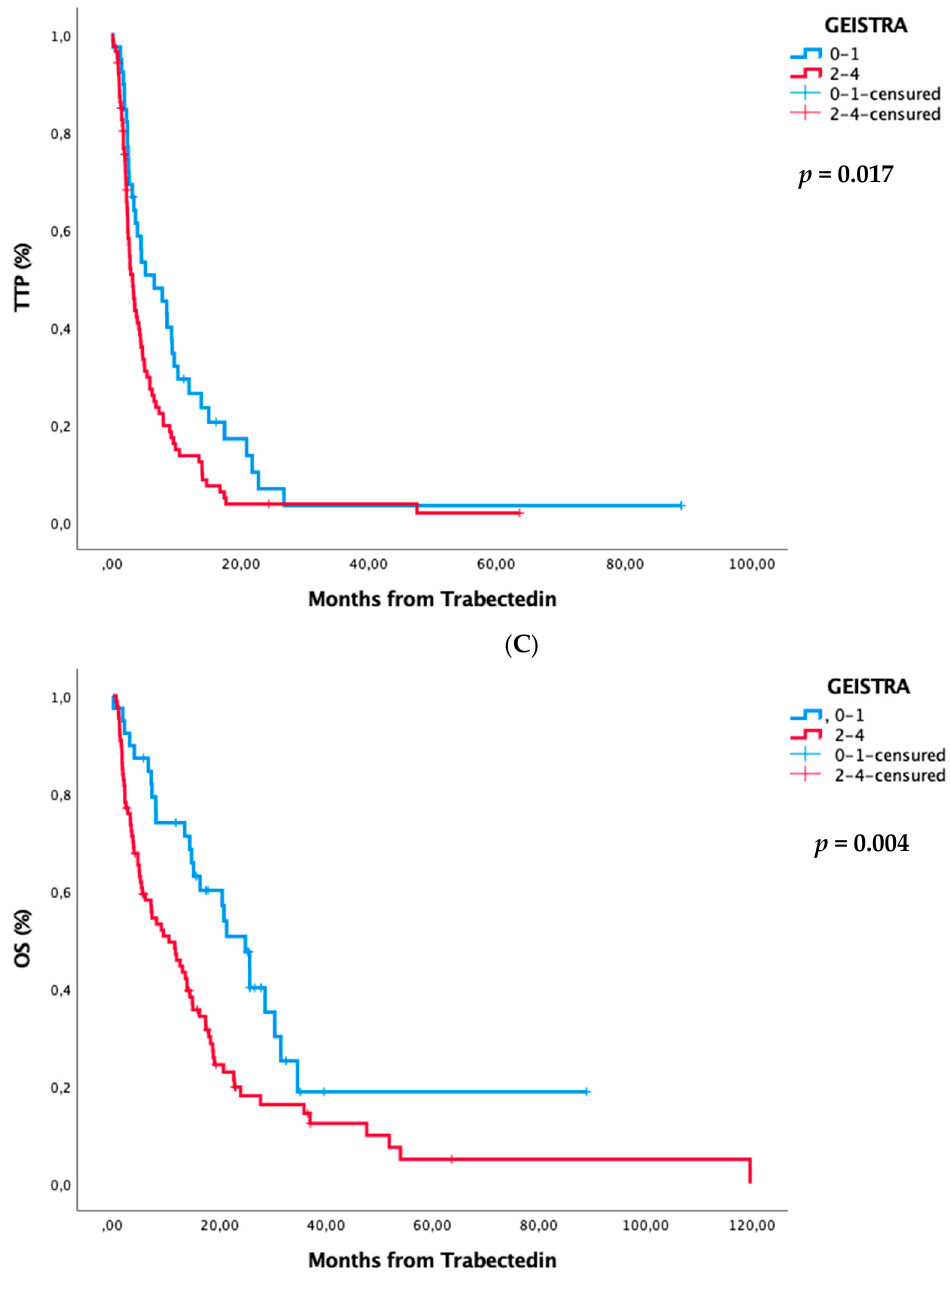
Figure 1. Time to progression and overall survival curves according to GEISTRA score in the training ( A , B ) and validation ( C , D ) cohorts.